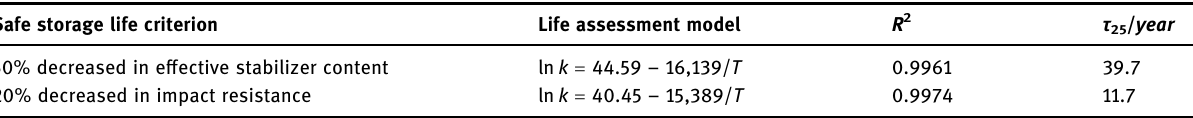
Table 5: Safe storage life predicted via Arrhenius approaches at 25°C Safe storage life